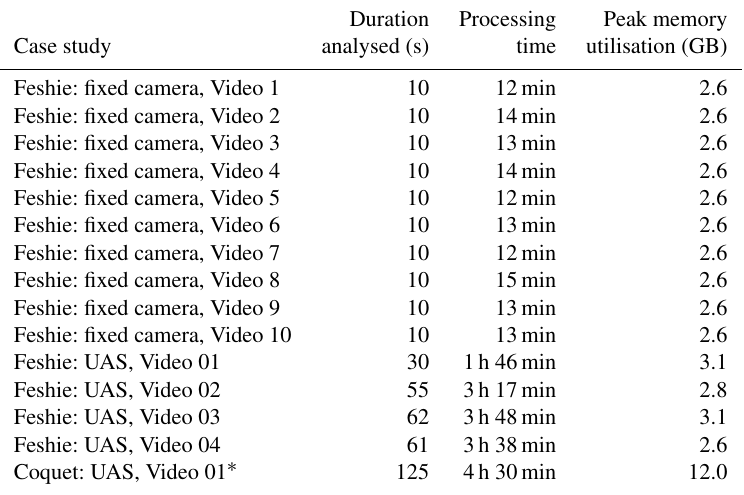
Table B1. Total processing time and typical memory utilisation of KLT-IV v1.0 when processing videos from the Feshie and Coquet case studies. The settings used during processing are defined within the data repository (Perks, 2020). Tests were conducted using a Dell Latitude 7490 laptop running Windows 10, equipped with a four-core Intel i5-8350U CPU at 1.70GHz and 16GB RAM. Processing time primarily increases as a function of the total number of frames analysed, the area (m 2 ) imaged, and the number of features detected and tracked. Memory utilisation primarily increases with the area (m 2 ) imaged. Duration